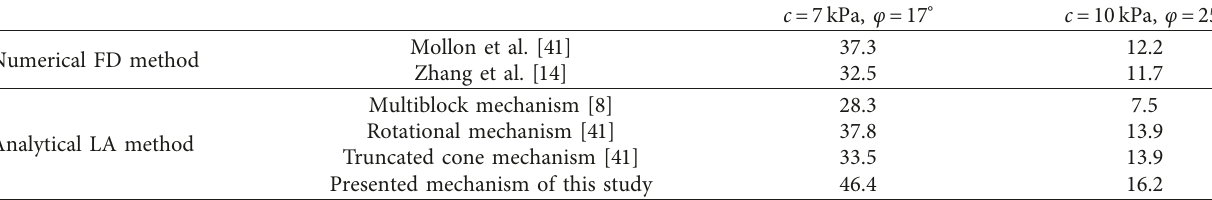
18kN/m 3 and D 10m). (cid:29) (cid:29) 10m, C 10m, and c 18kN/m 3 . (cid:29) (cid:29) (cid:29)